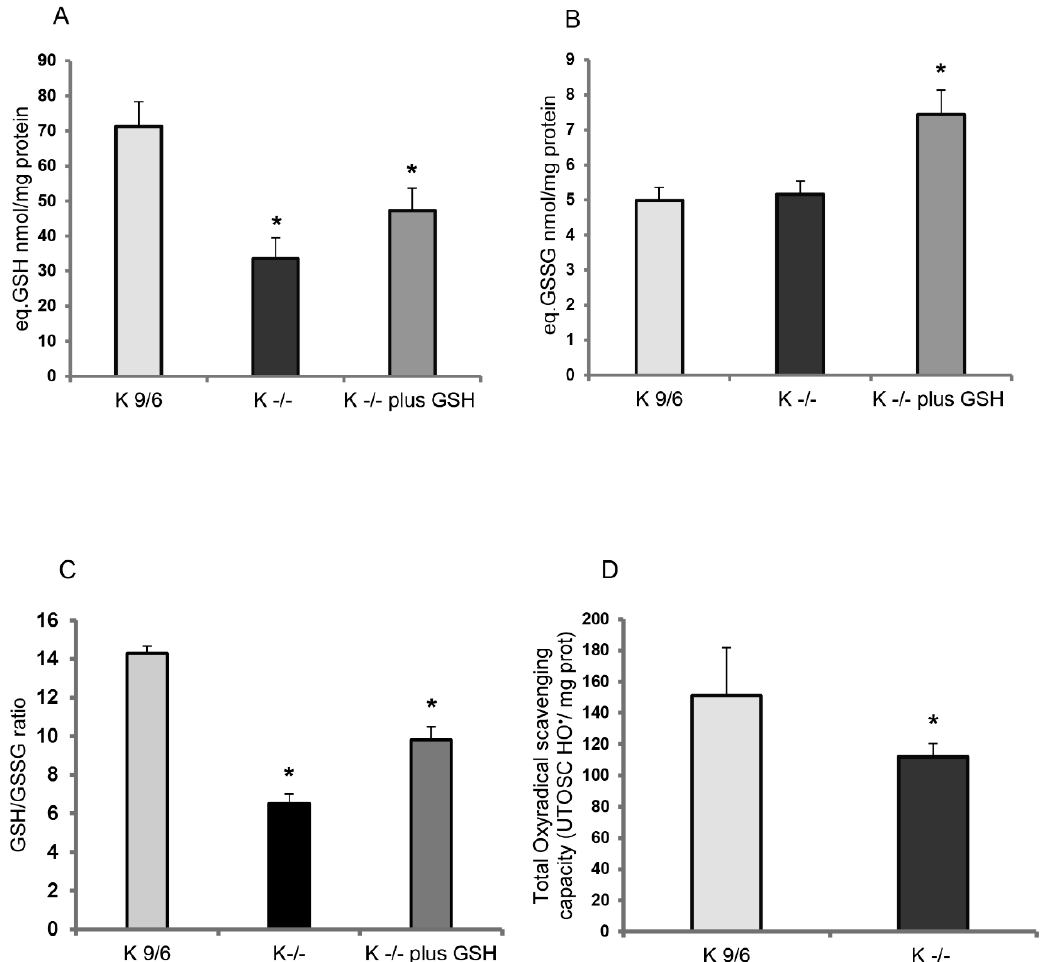
Figure 1. KRIT1 loss-of-function induces GSH depletion. ( A , B ) The amounts of total glutathione (GSH+GSSG in GSH equivalents) (A) and oxidized glutathione (GSSG) (B) were quantified in K − / − cells left untreated or treated for 4 h with liposome-encapsulated GSH (5 mM final concentration) by an established enzymatic recycling assay, as described in Materials and Methods. K 9/6 cells were used as control. ( C ) Histogram representing the GSH/GSSG ratio. ( D ) Total antioxidant capacity for peroxyl radicals in K 9/6 and K − / − cells, as determined by the total oxyradical scavenging capacity (TOSC) assay described in Materials and Methods. For all measurements, TOSC values were referred to protein concentration counterparts. Results are reported as mean values ± standard deviation (S.D.) of six different experiments. Asterisks above histogram bars indicate significant differences ( p ≤ 0.05) between groups of means (post hoc comparison).